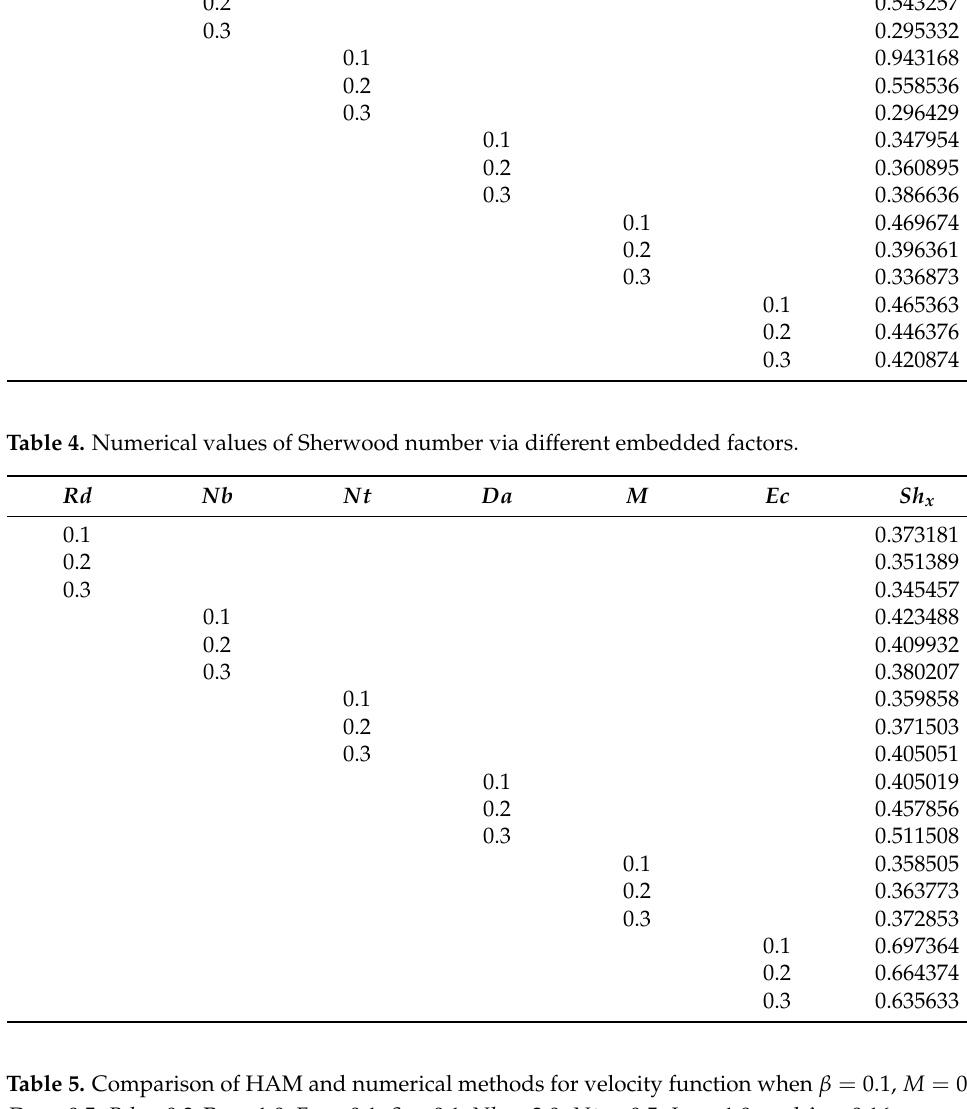
Table 5. Comparison of HAM and numerical methods for velocity function when β = 0.1, M =